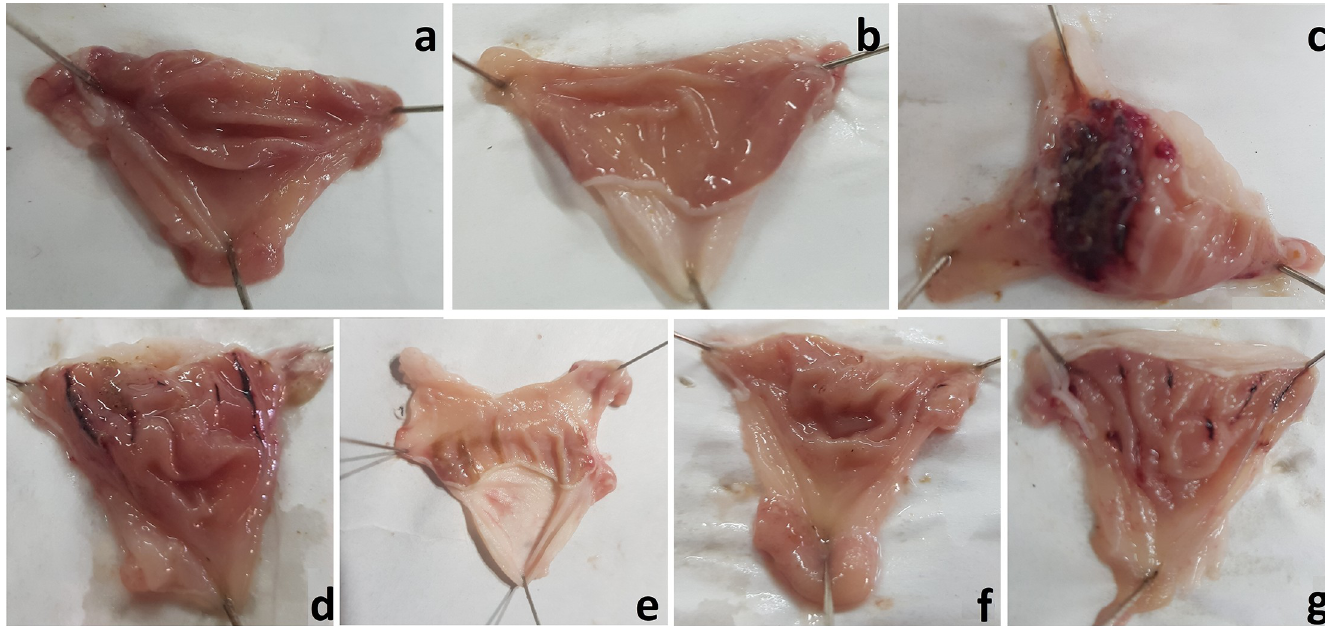
Fig 3. Effect of prodigiosins on gross lesions in rat stomach. (a) Stomach of control rats. (b) Stomach of the rats treated with prodigiosins (300 mg/kg) alone. (c) Stomach of the rats treated with HCl/ethanol alone. (d) Stomach of the rats pretreated with prodigiosins 100 mg/kg 1 h before HCl/ethanol treatment. (e) Stomach of the rats treated with prodigiosins 200 mg/kg 1 h before HCl/ethanol treatment. (f) Stomach of the rats treated with prodigiosins 300 mg/kg 1 h before HCl/ethanol treatment. (g) Stomach of rats treated with omeprazole (20 mg/kg) 1 h before HCl/ethanol treatment.